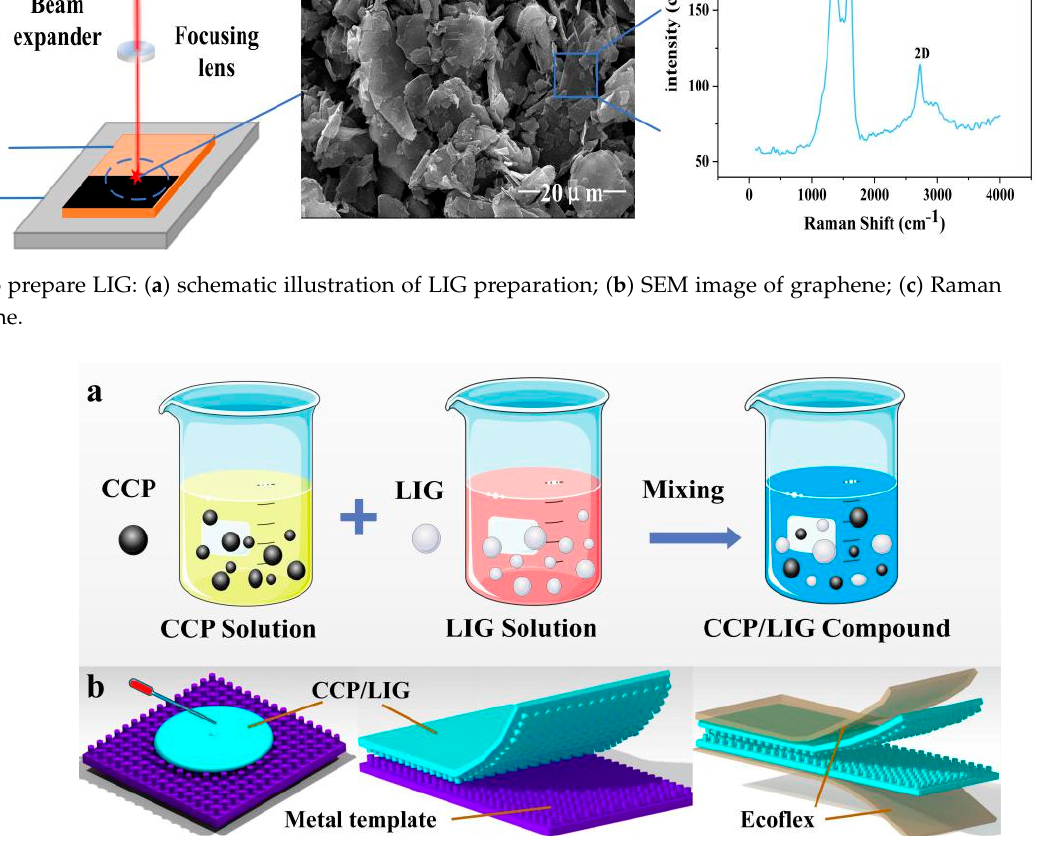
Figure 2. Manufacturing process of the flexible pressure sensor: ( a ) preparation of CCP/LIG disper- sions; ( b ) schematic diagram of the preparation of the flexible pressure sensor.